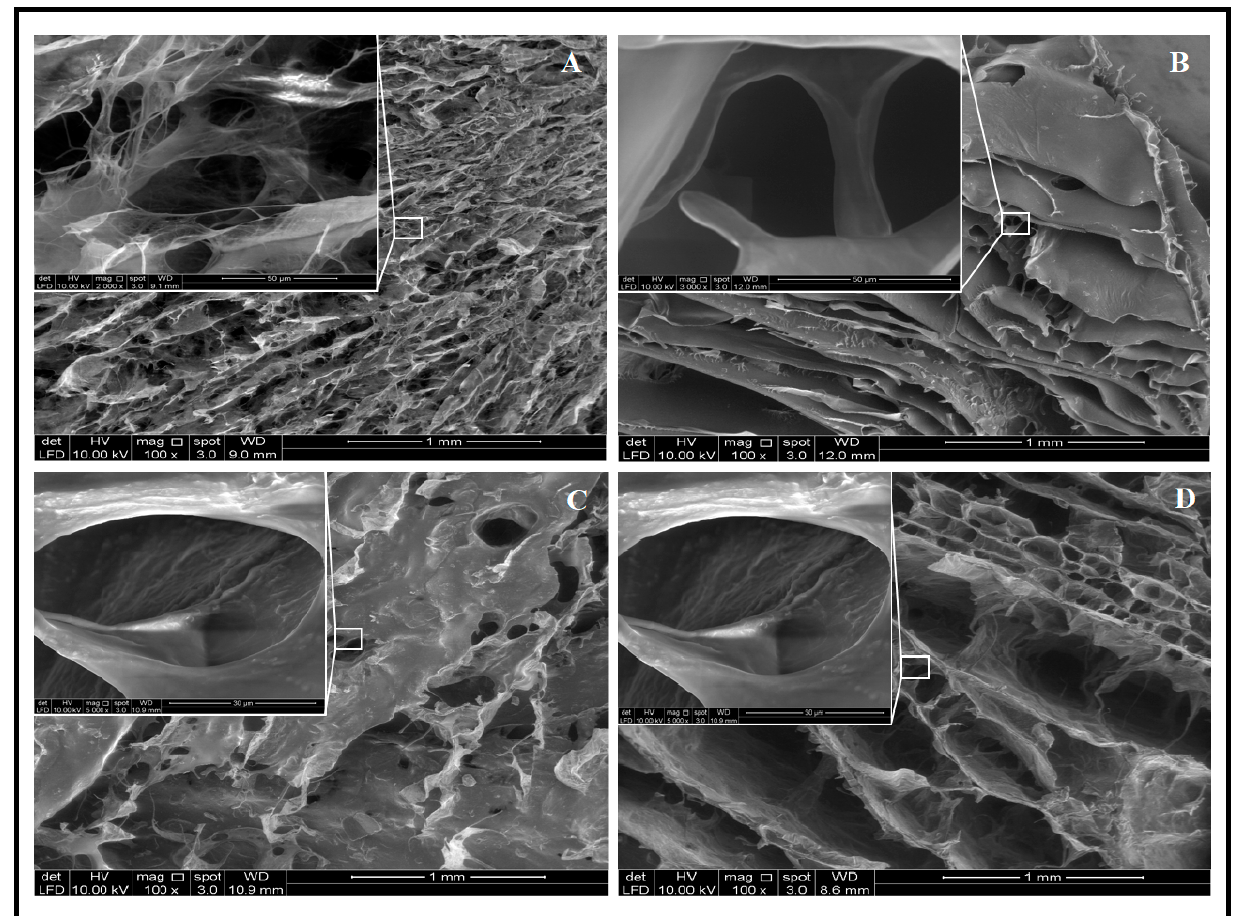
Figure 2. Field-Emission Scanning Electron Microscope (FE-SEM) images of aerogels: ( A ) pure-CNFs aerogel, ( B ) pure-CS aerogel, ( C ) 60–40 CNFs/CS and ( D ) 40–60 CNFs/CS. Table 1. Results of texture profile analysis of prepared aerogel samples (mean ± S.D).